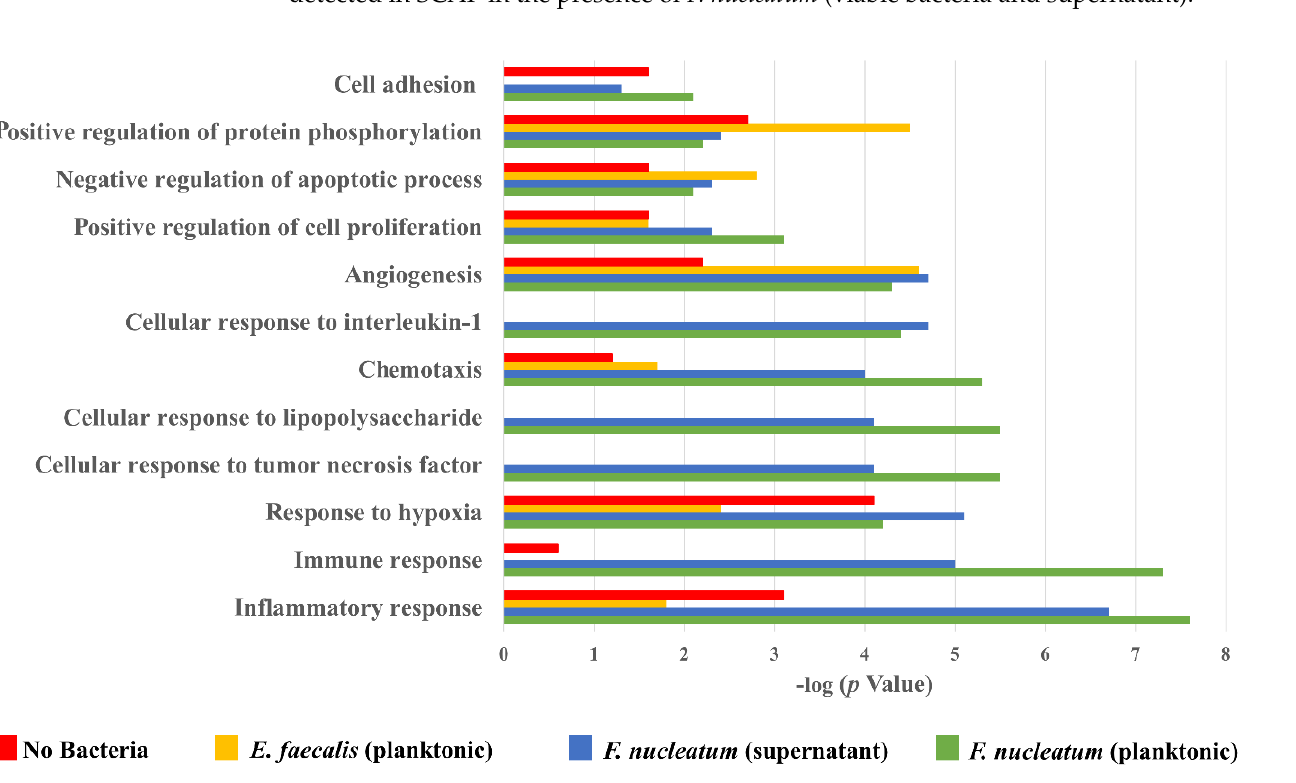
Figure 7. GO annotated biological processes in different variants of SCAP treatment. Coverage in each variant is 100%.